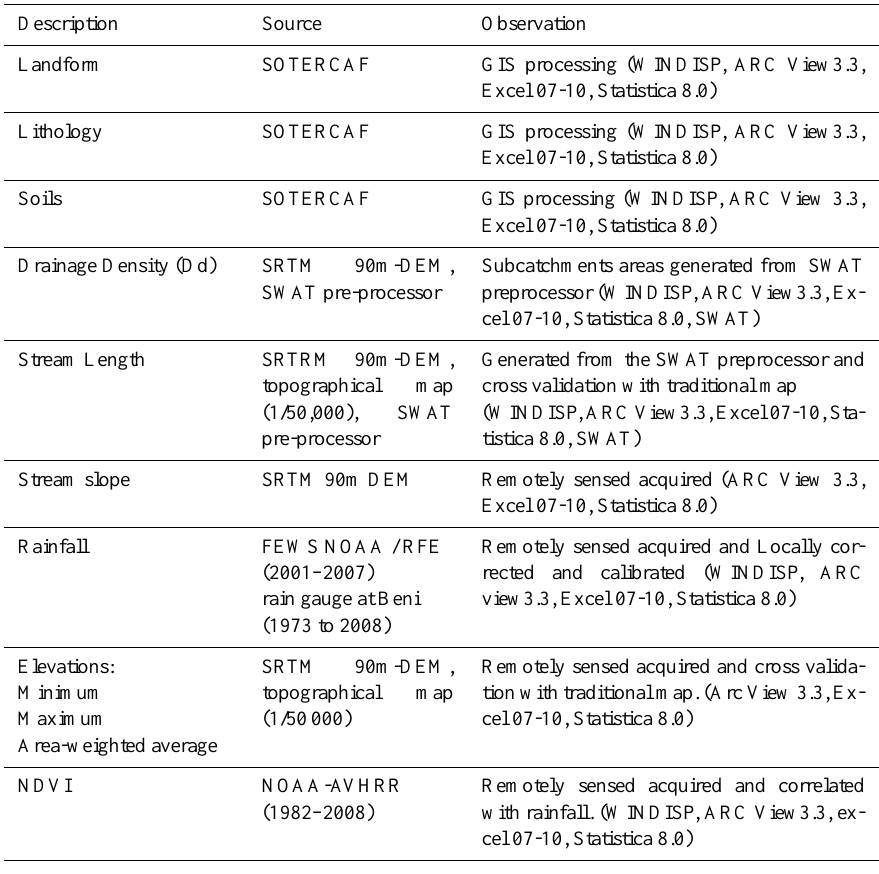
Table 2. Generated landscape attributes for subcatchments (S3–S23).